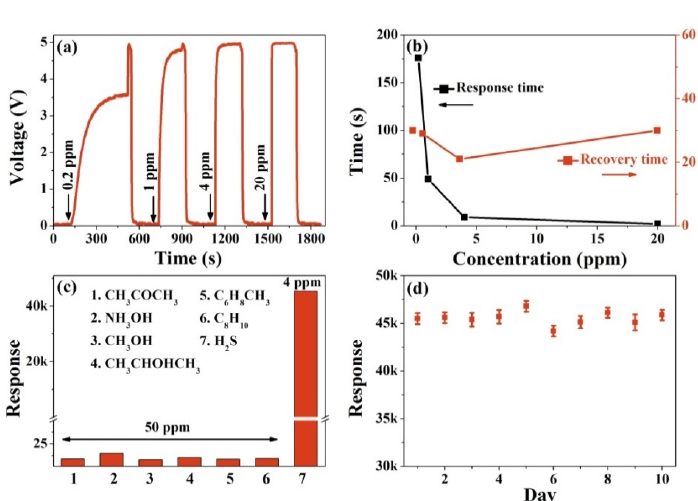
Figure A2. Gas sensing performances of the CuO/WO 3 (1:10) sensor at 40 °C. ( a ) Real ‐ time V out cures of sensor to 0.2, 1, 4, and 20 ppm of H 2 S; ( b ) response and recovery times of the sensor to various concentrations of H 2 S; ( c ) the selectivity of the sensor to H 2 S and other gases; and ( d ) repeating stability testing for 10 days using a H 2 S concentration of 4